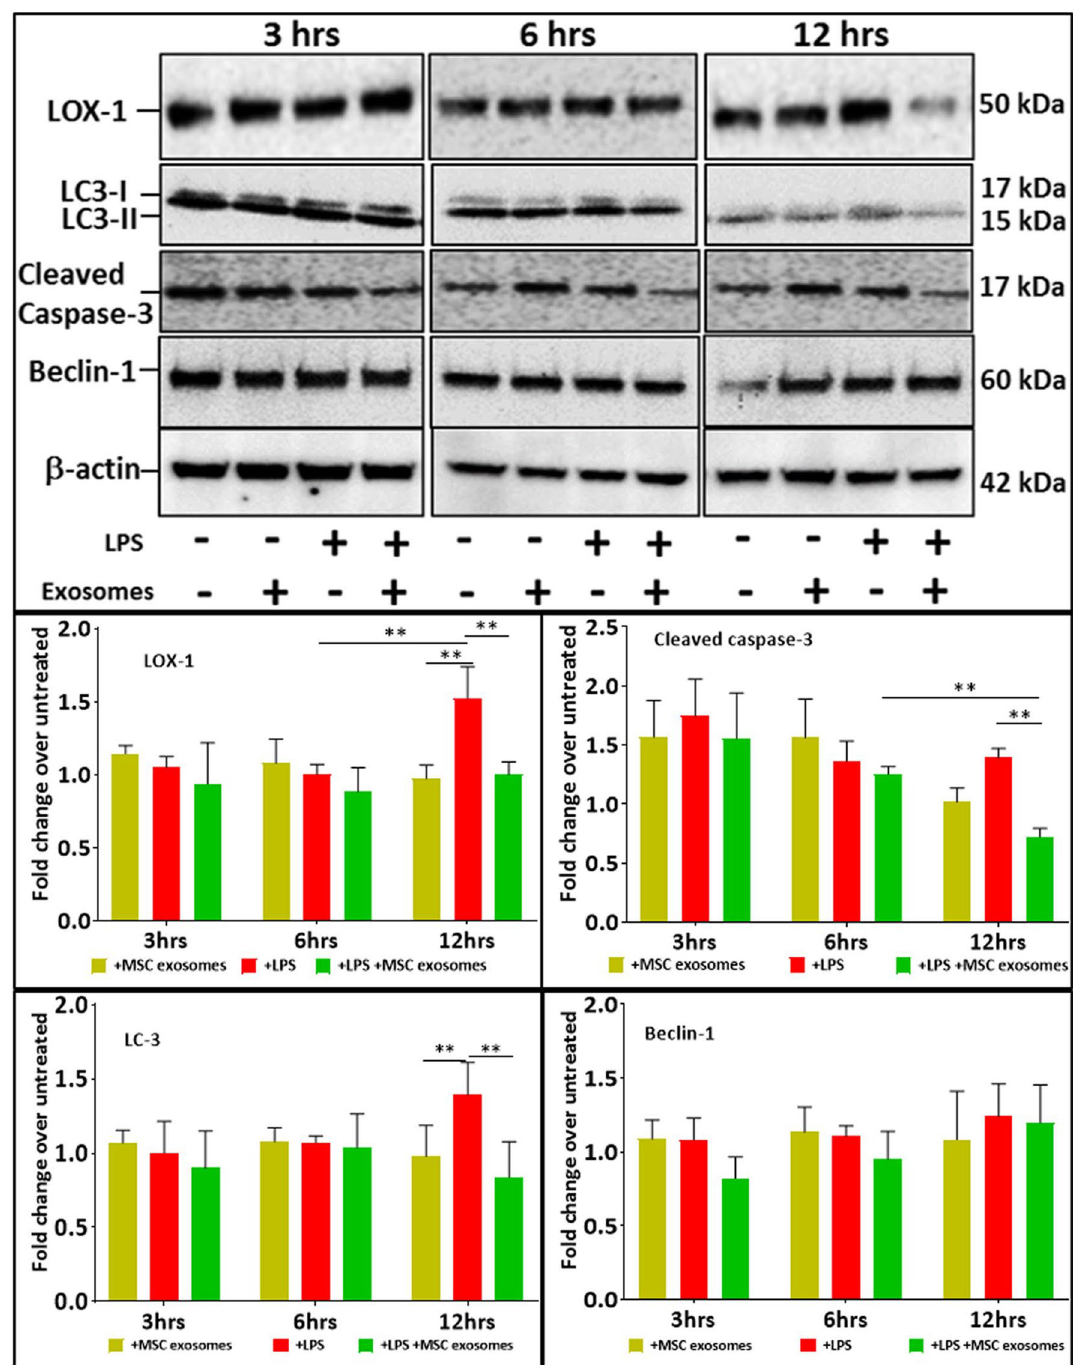
Figure 2. Monolayer cultures of cardiomyocytes were exposed to LPS (100 ng/ml) for 1 hour and then treated with MSC exosomes. LPS induced LOX-1 expression at 12 hrs of exposure. LPS also induced apoptosis (cleaved Caspase-3) and autophagy (LC3). Treatment with MSC exosomes decreased LOX-1, cleaved caspase-3 and LC-3 levels in cardiomyocytes stressed with LPS over a period of 6–12 hrs, but had no effect on expression of Beclin-1. LOX-1 levels were decreased with MSC exosomes. Data in mean ± SD, n = 4 *p < 0.05, vs LPS treatment based on 3 independent experiments. Full-length blots are presented in Supplementary Fig.